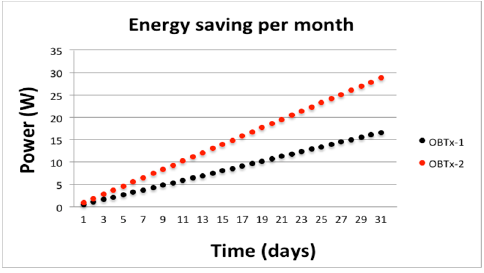
Figure 13. Scaling energy saving of a day ( k = 2) in a month ( k = 62).